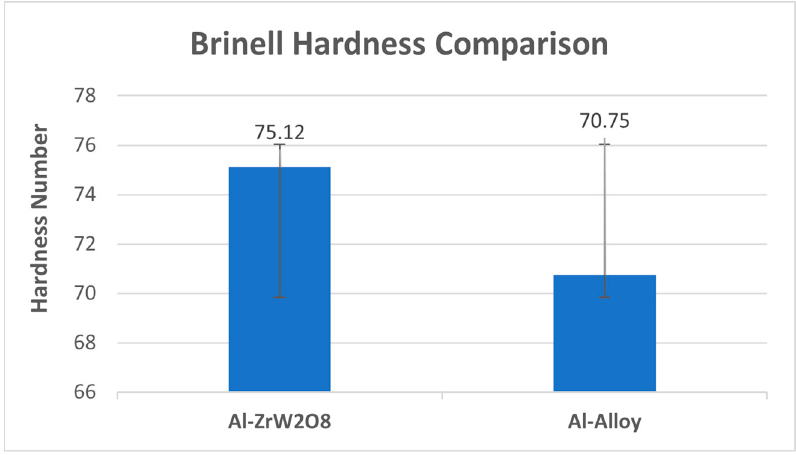
Figure 8. Brinell Hardness value of base aluminum alloy and Al/ZrW 2 O 8 with standard deviation.